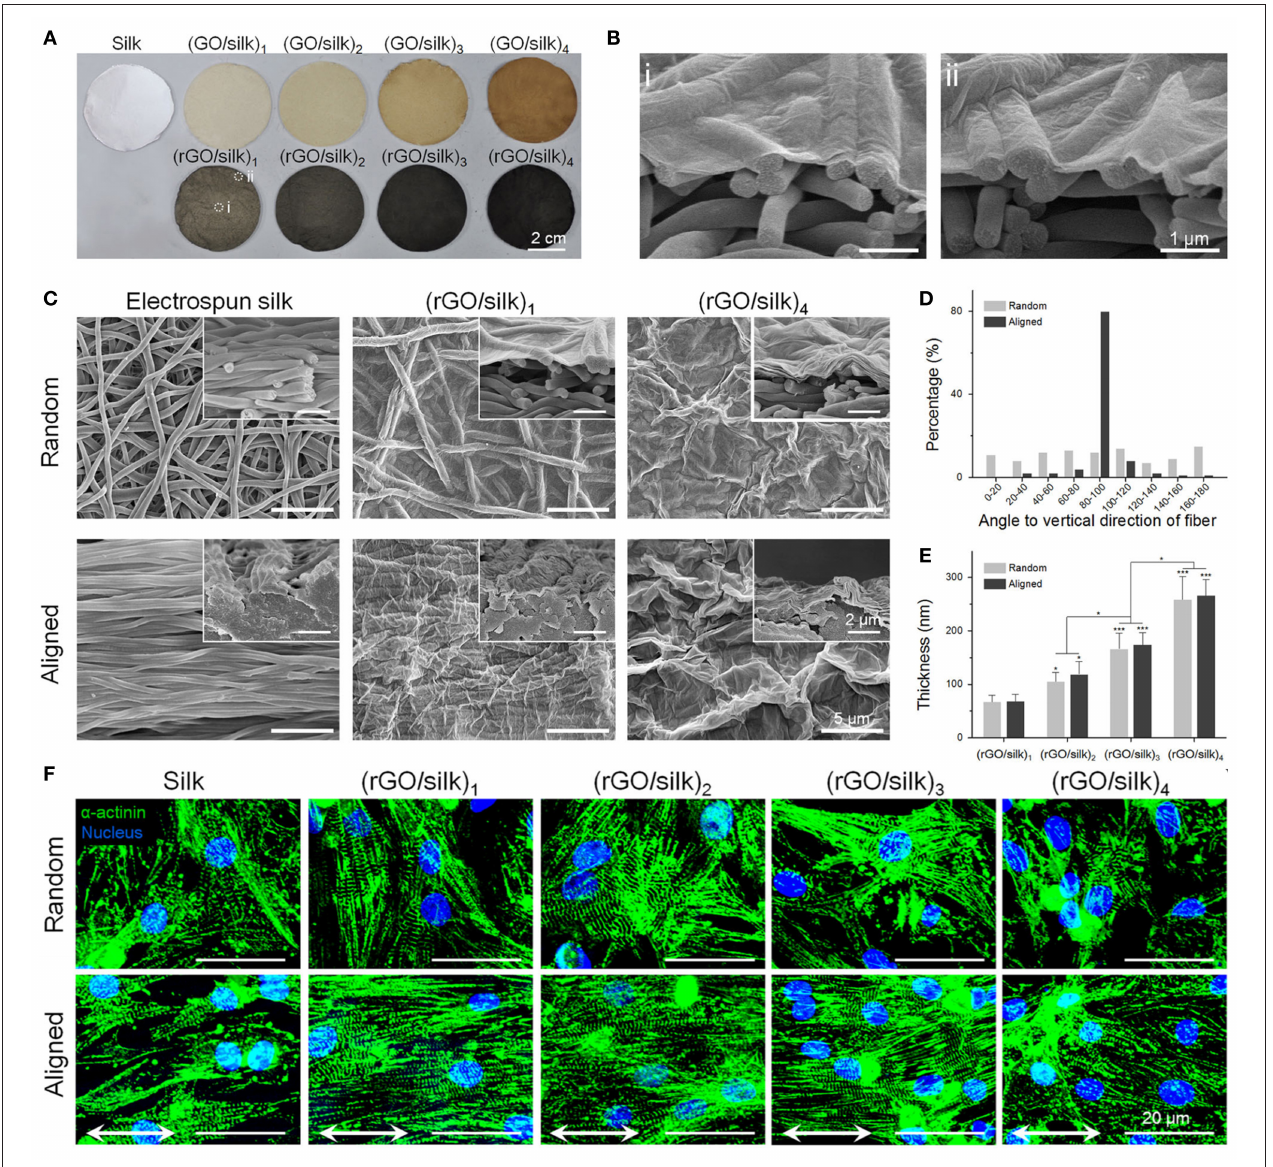
FIGURE 8 | Photographic and morphologic characterizations on rGO/silk biomaterials. (A) Images of random silk, GO/silk, and rGO/silk materials. (B) Cross-sectional images of rGO/silk materials in the (i) central and (ii) marginal regions in (A) show no distinction in rGO coating thickness. (C) SEM images of the surface and cross-section of silk and rGO/silk scaffolds, showing an integrated rGO layer and a nanofibrous morphology that is controllable based on the coating thickness. (D) Fibre orientation distribution of random and aligned electrospun silk matrices. (E) rGO coating thickness shows a positive relationship with the GO doping mass. (F) Immunofluorescence show α -actinin expression for cardiomyocytes after day 7. Reproduced with permission from Zhao et al. (124). A significant difference is defined as * p < 0.05,** p < 0.01,*** p <